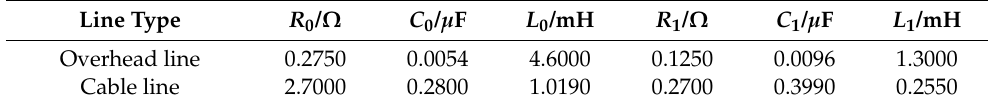
Table 1. Line parameters of the simulation